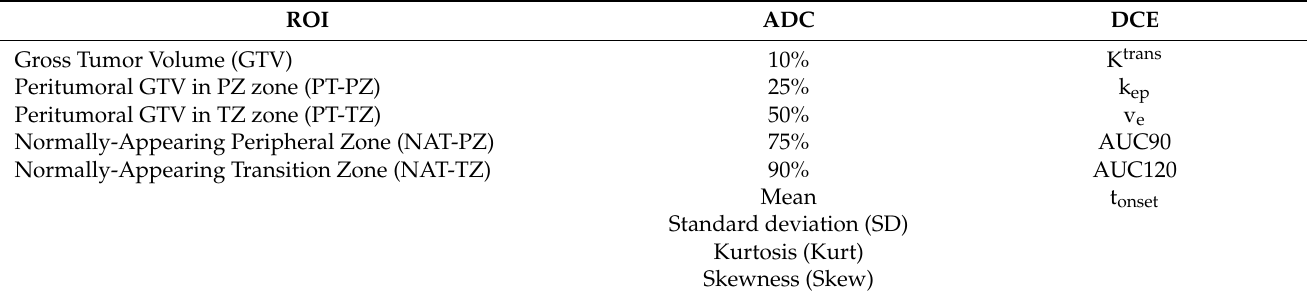
Table 1. Radiomics variables and the abbreviations used in radiomics variables name-convention *. ROI ADC DCE Gross Tumor Volume (GTV) 10% K trans Peritumoral GTV in PZ zone (PT-PZ) 25% k ep Peritumoral GTV in TZ zone (PT-TZ) 50% v e Normally-Appearing Peripheral Zone